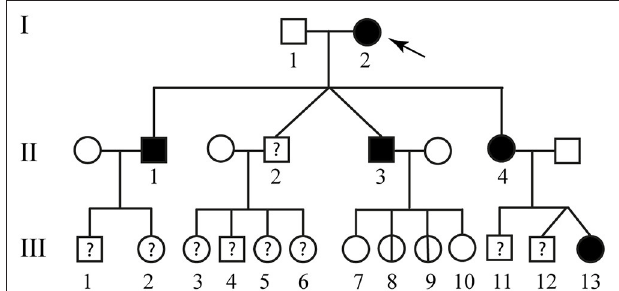
FIGURE 2 | Familial pedigree of case report 2. The arrow indicates the proband. Healthy members are indicated by empty symbols. Empty circles vertically crossed refer to healthy carrier mutation. Affected ones are represented by black filled. By question mark are indicated consanguineous of which no genotype or phenotype data are